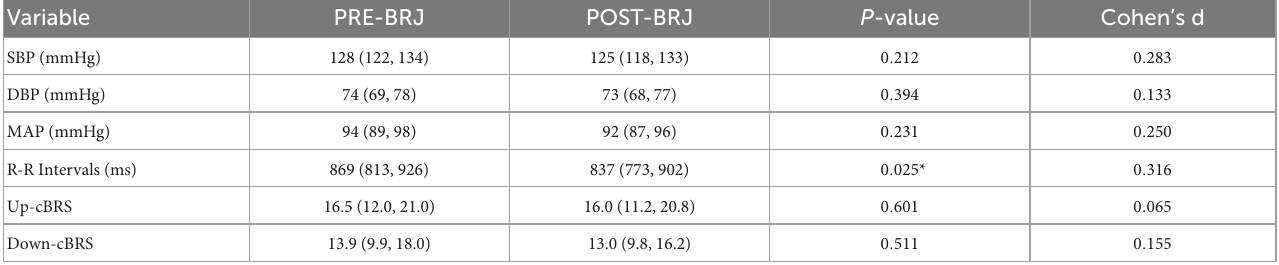
TABLE 2 Blood pressure and cardiovagal baroreflex sensitivity values during oscillatory lower-body negative pressure before and 3 h after beetroot juice (BRJ) consumption. Variable